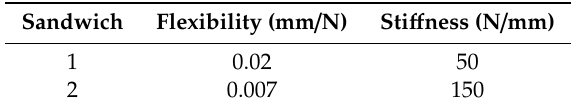
Table 4. Mean values of sti ff ness and flexibility for both